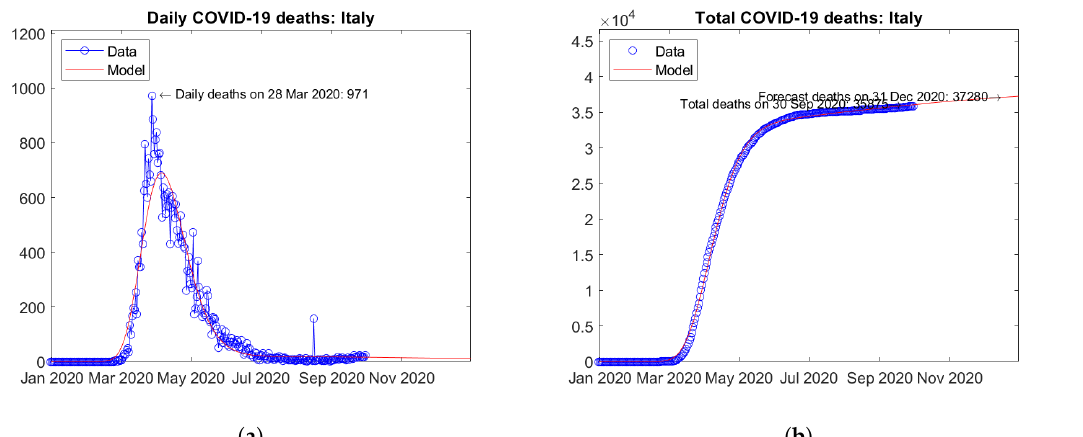
Figure 11. Actual and predicted trends in Italy: ( a ) daily deaths, ( b ) total deaths.